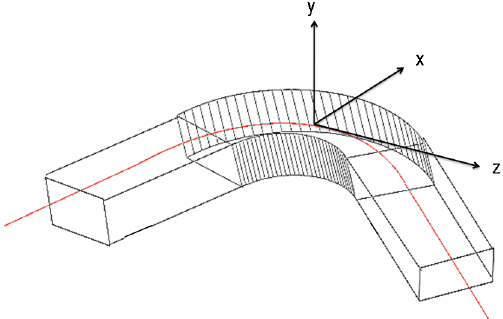
FIG. 26. (Color) Illustration of a bent box with straight ends, used for computing a transfer map for bending dipoles with large sagitta. A design orbit is illustrated in red.